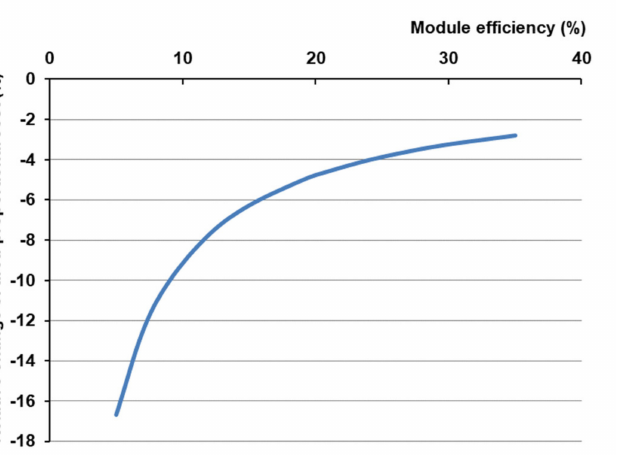
Figure 3. The relative changes of area-related costs caused by a 1% increase in module efficiency calculated for Equation